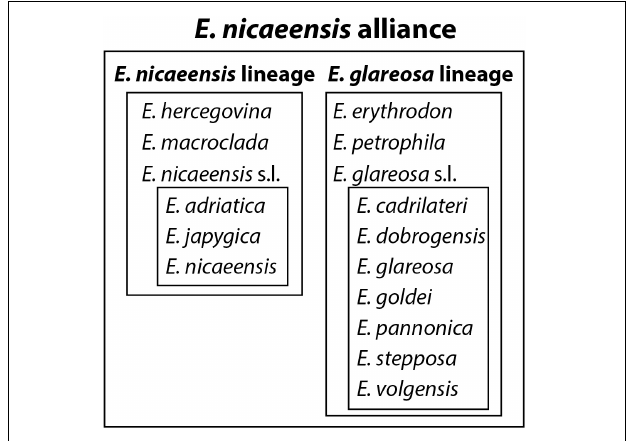
FIGURE 9 | Relations amongst taxa within the E. nicaeensis alliance as a result of the outcomes of this study, combined with previous treatments within E. glareosa s.l., which were not addressed in this study.